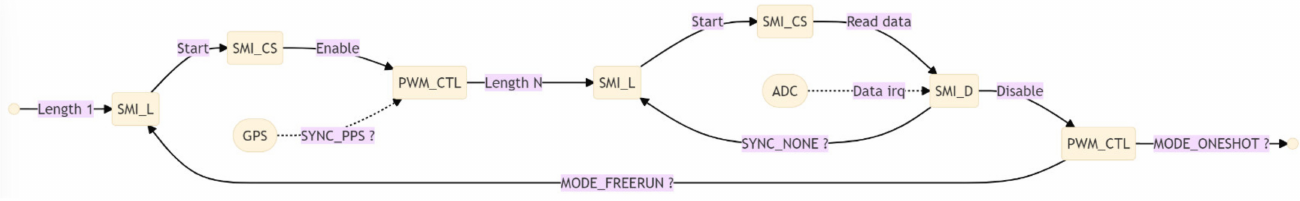
Figure 6. State diagram of the DMA finite state machine for synchronization and data